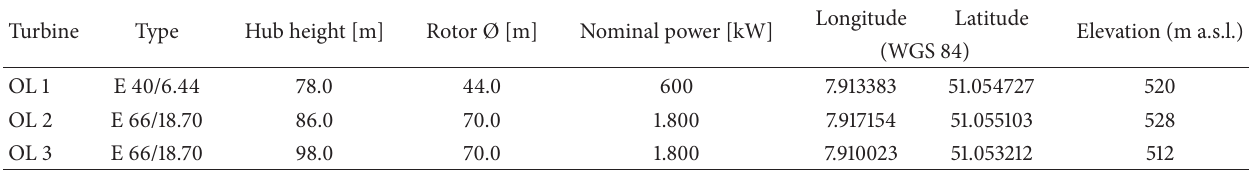
Table 11: Coordinates and data of wind turbines at the site Olpe .